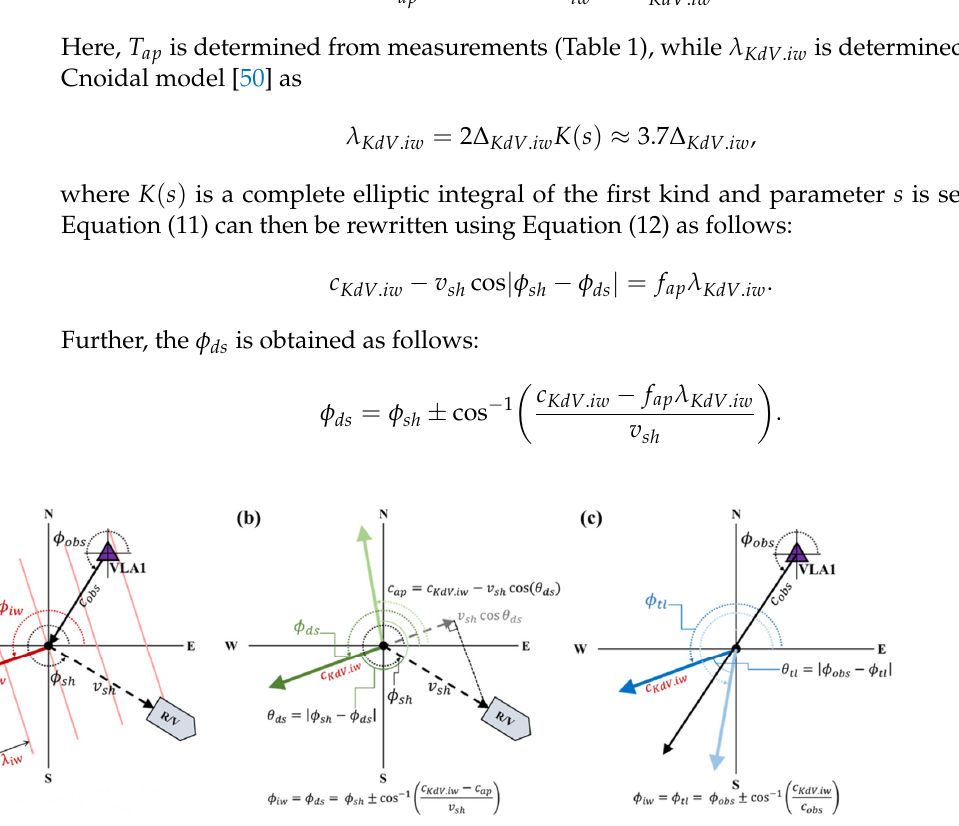
Figure 2. Schematic description of ( a ) the definition of parameters and estimation of the NLIW propagating direction based on the ( b ) Doppler shift and ( c ) time lag.